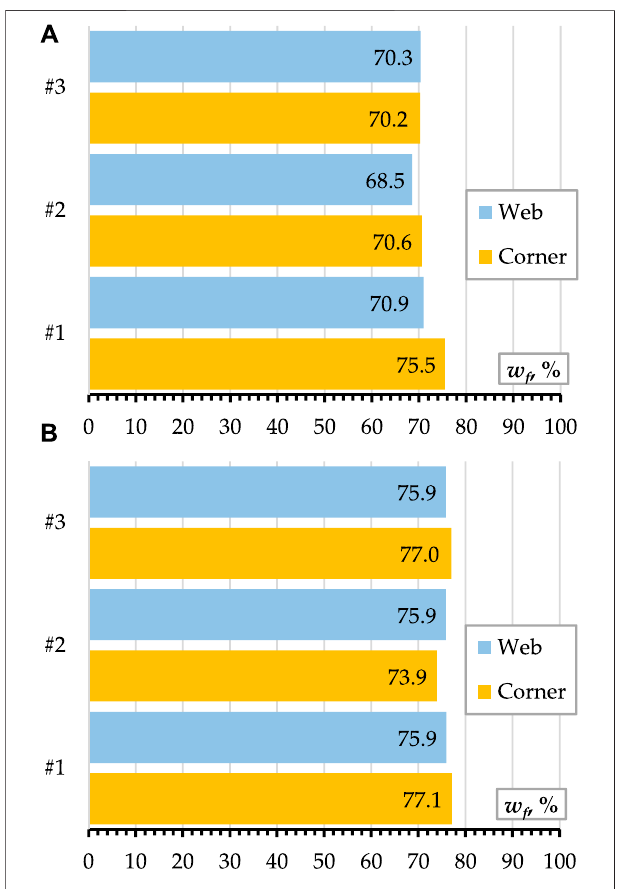
FIGURE 3 | Estimated mass fi ber fraction in GFRP composite: (A) F IBERLINE pro fi le; (B) U GIRA